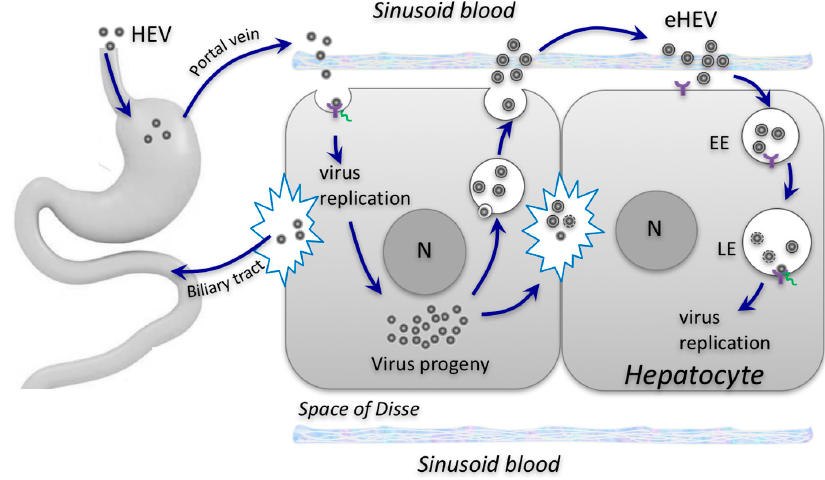
Figure 2. Proposed model for HEV entry and spread. Non-enveloped HEV virions (HEV) are acquired orally and enter the bloodstream via an unknown mechanism. They infect, propagate, and are then released from the basolateral (sinusoidal) sides of hepatocytes into the bloodstream as quasi-enveloped virions (eHEV). eHEV mediate subsequent rounds of infection within the liver. Virions are also released from the apical (bile canaliculi) side of infected hepatocytes and excreted via the biliary tract into the feces. Non-enveloped and enveloped HEV particles enter cells via distinct pathways, but likely use the same putative cellular receptor (purple) that is present both at the cell surface and on the endosomal membrane. EE, early endosome. LE, late endosomes. N, nucleus.